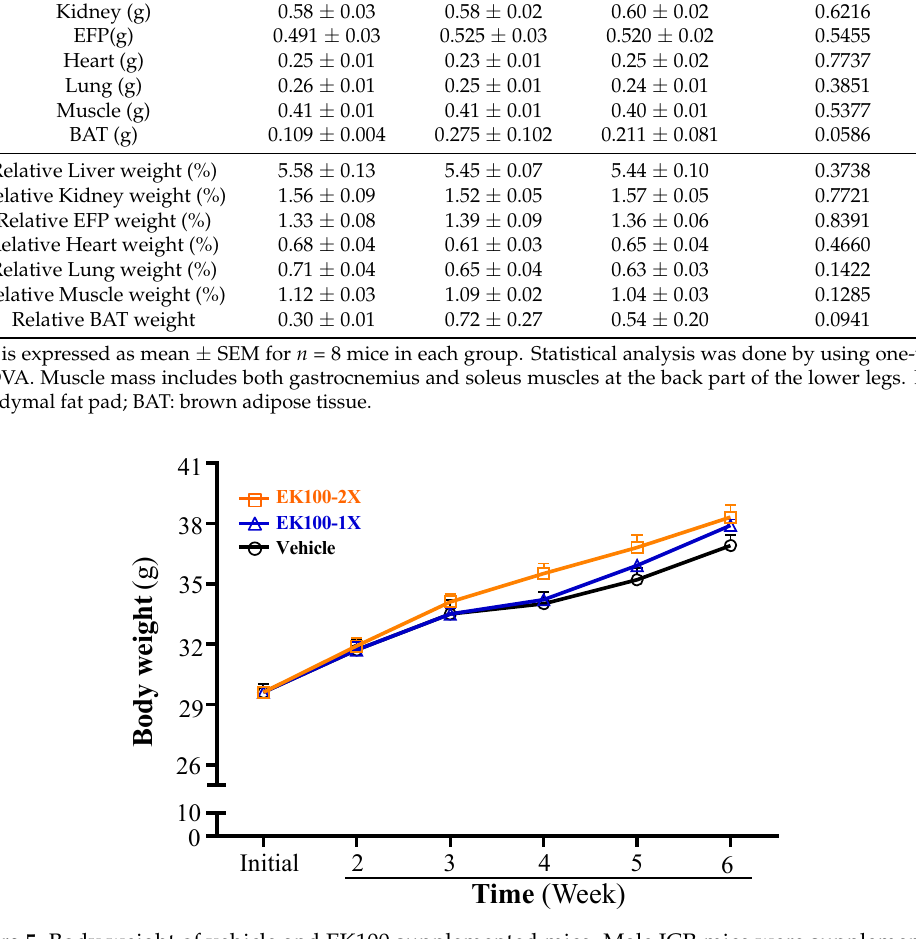
Figure 5. Body weight of vehicle and EK100 supplemented mice. Male ICR mice were supplemented with vehicle, 10 (EK100-1X), and 20 (EK100-2X) mg/kg EK100 for six-weeks. Data is expressed as mean ± SEM for n = 8 mice per group.